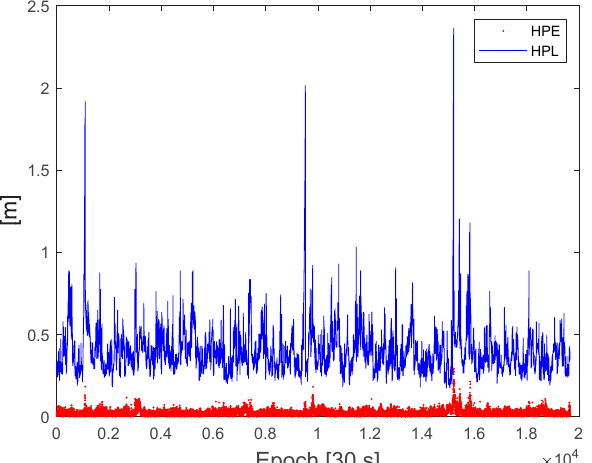
Figure 8. Comparison of the horizontal protection levels and horizontal position errors from the test dataset.